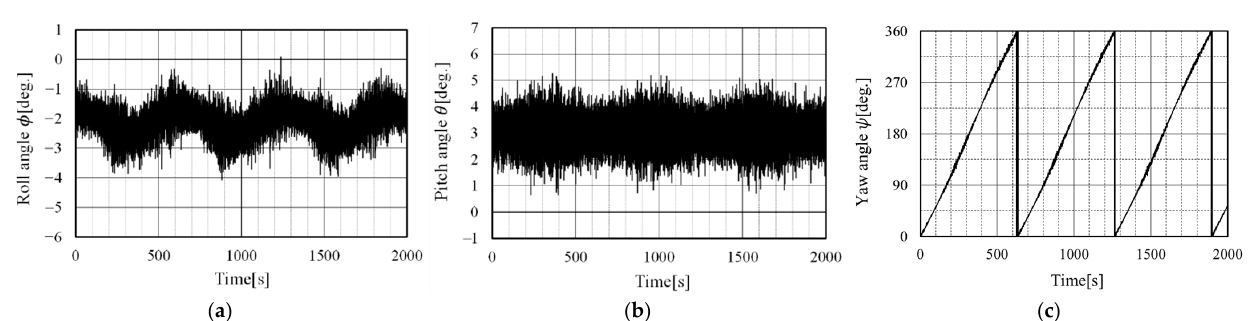
Figure 20. Time history of fixed-wing UAV’s attitude. ( a ) Roll angle. ( b ) Pitch angle. ( c ) Yaw angle.